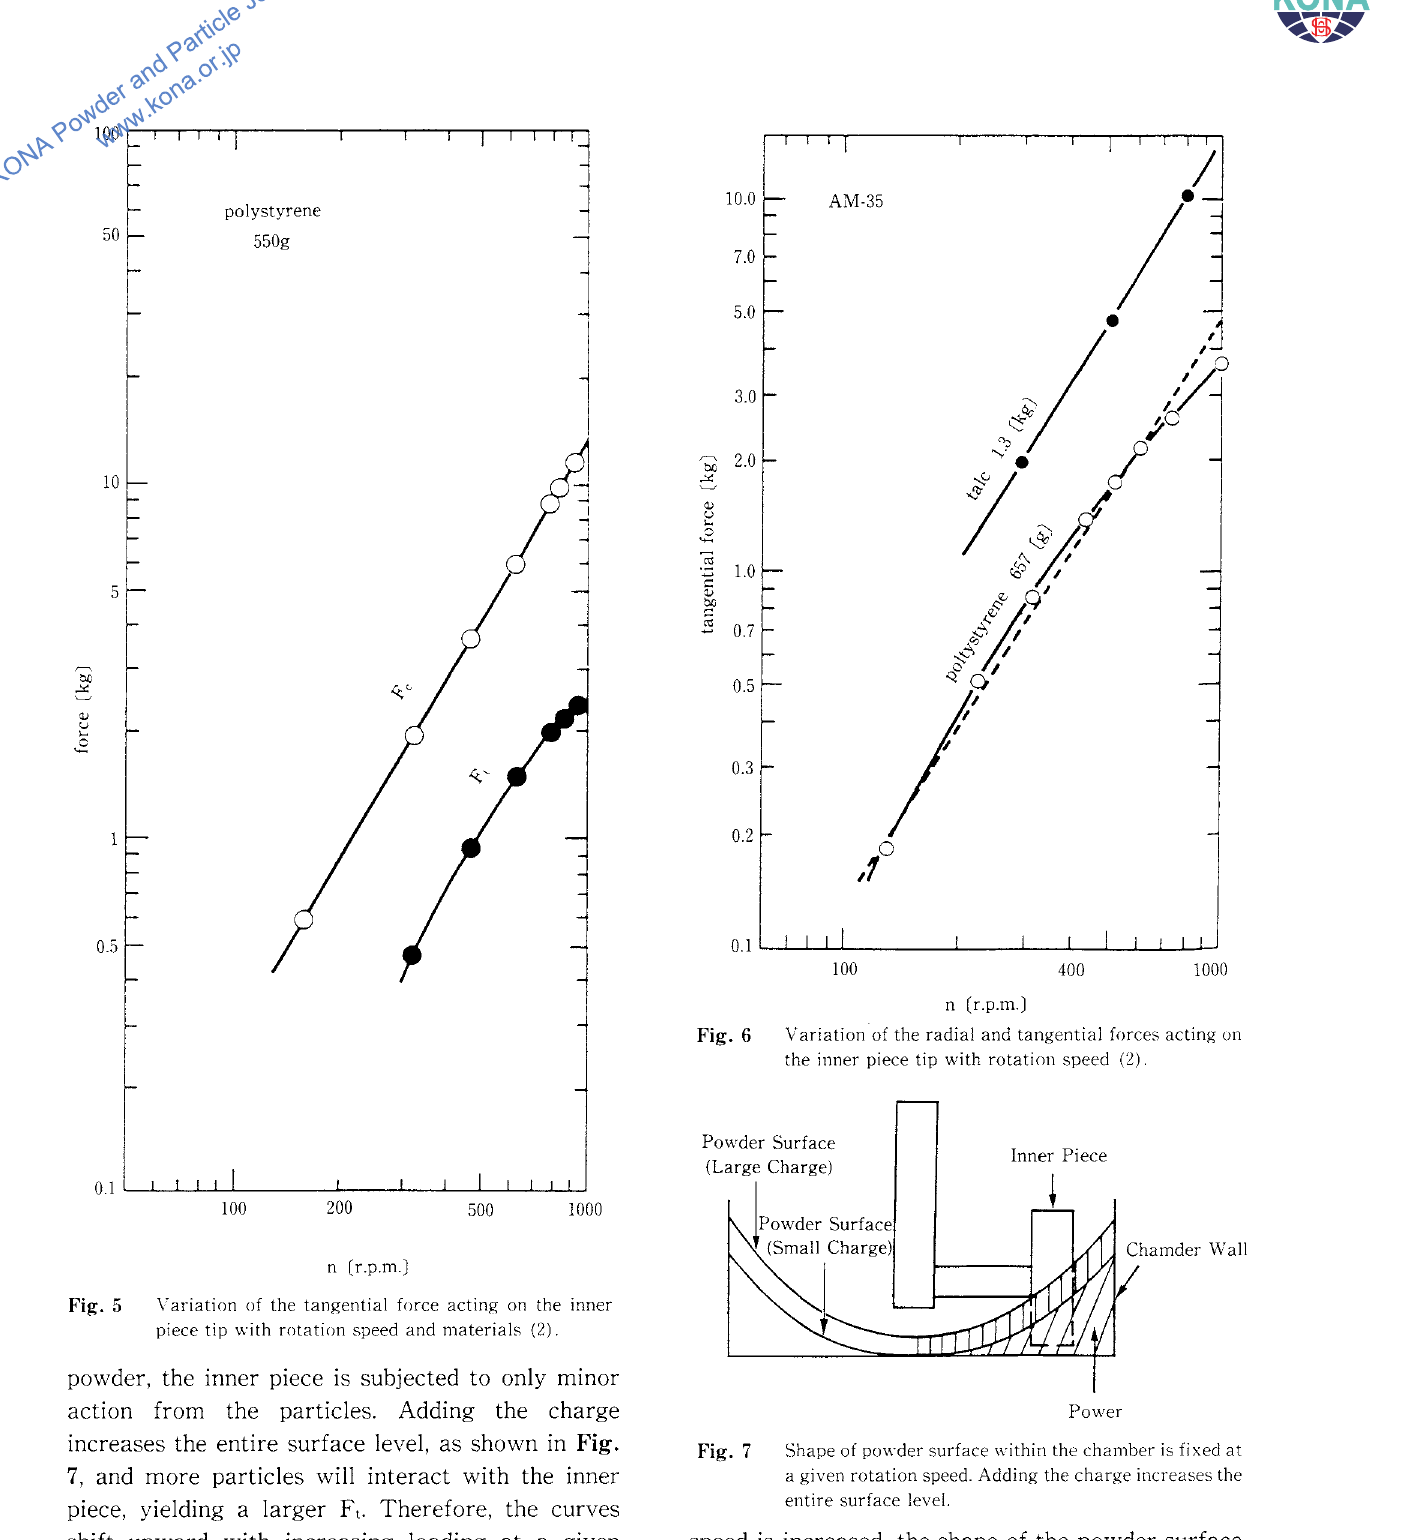
Shape of powder surface within the chamber is fixed at a given rotation speed. Adding the charge increases the entire surface